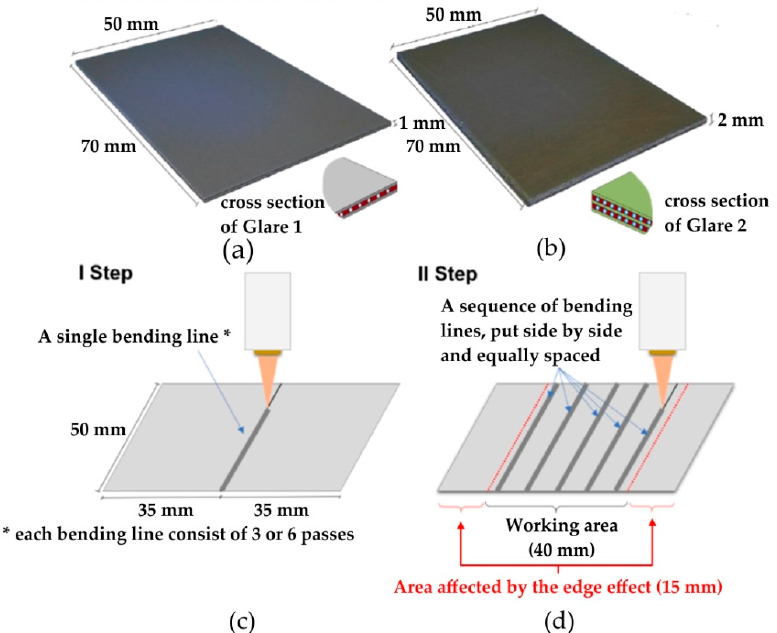
Figure 41. Visual appearance and cross-section of ( a ) GLARE 1 and ( b ) GLARE 2, and the experi- mental set-up of the ( c ) first and ( d ) second investigation (reproduced with permission from [385]; copyright© 2021 Elsevier Ltd.).